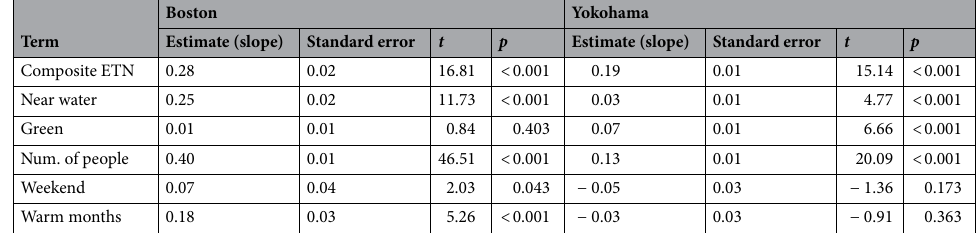
Table 6. The relation of ETN and temporal cycles phase with HFE prevalence. Standardized coefficient estimates are shown for those terms where the interaction with “study area” was significant, i.e., the relations differed among